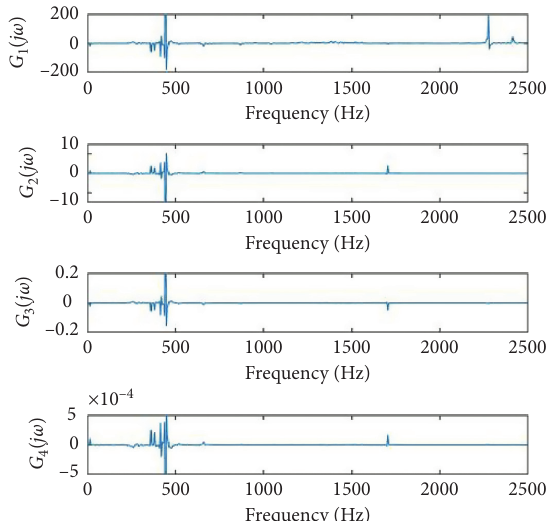
Figure 14: The NOFRFs of cracked pillar porcelain insulator in hammer